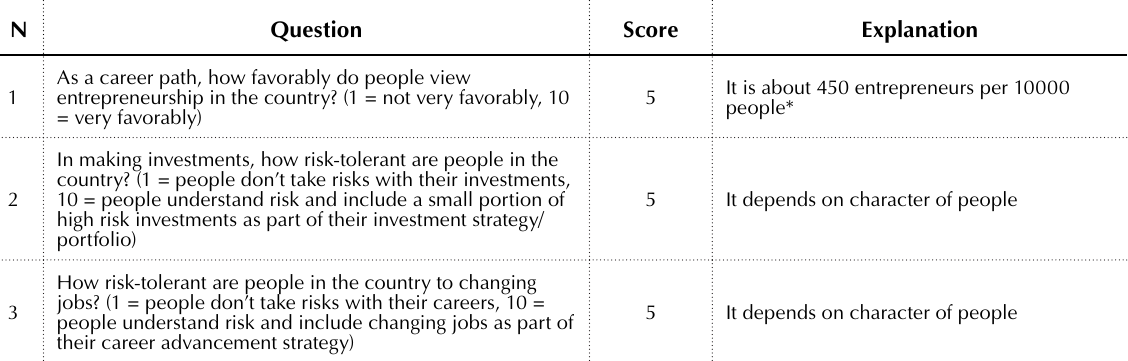
Table 4. Assessing a country’s readiness for crowdfunding: culture